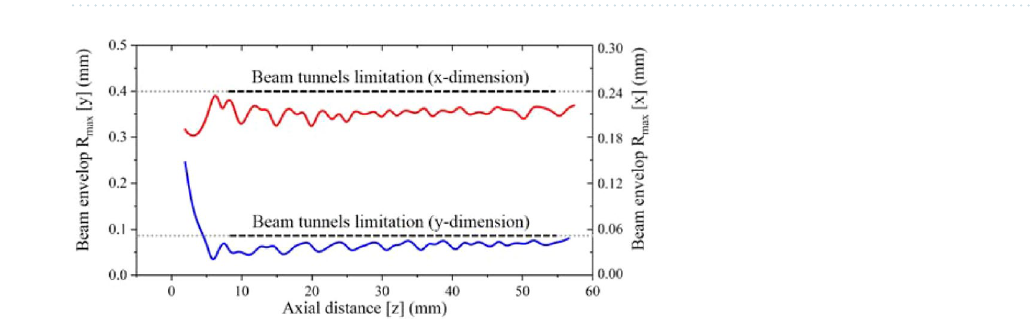
Figure 16. Cross sections of the electron beam at different positions away from the cathode (with focusing system).